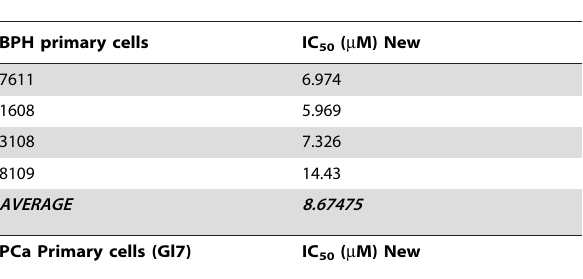
Table 4. IC 50 values of the Pd complex in primary cells.